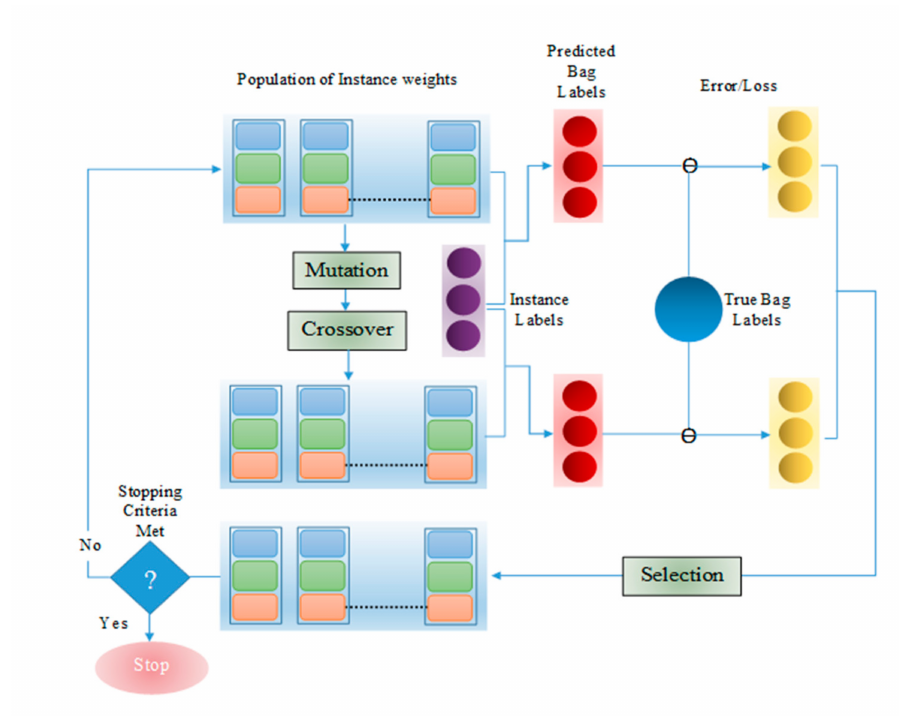
Figure 5. Instance weight optimization through DE.